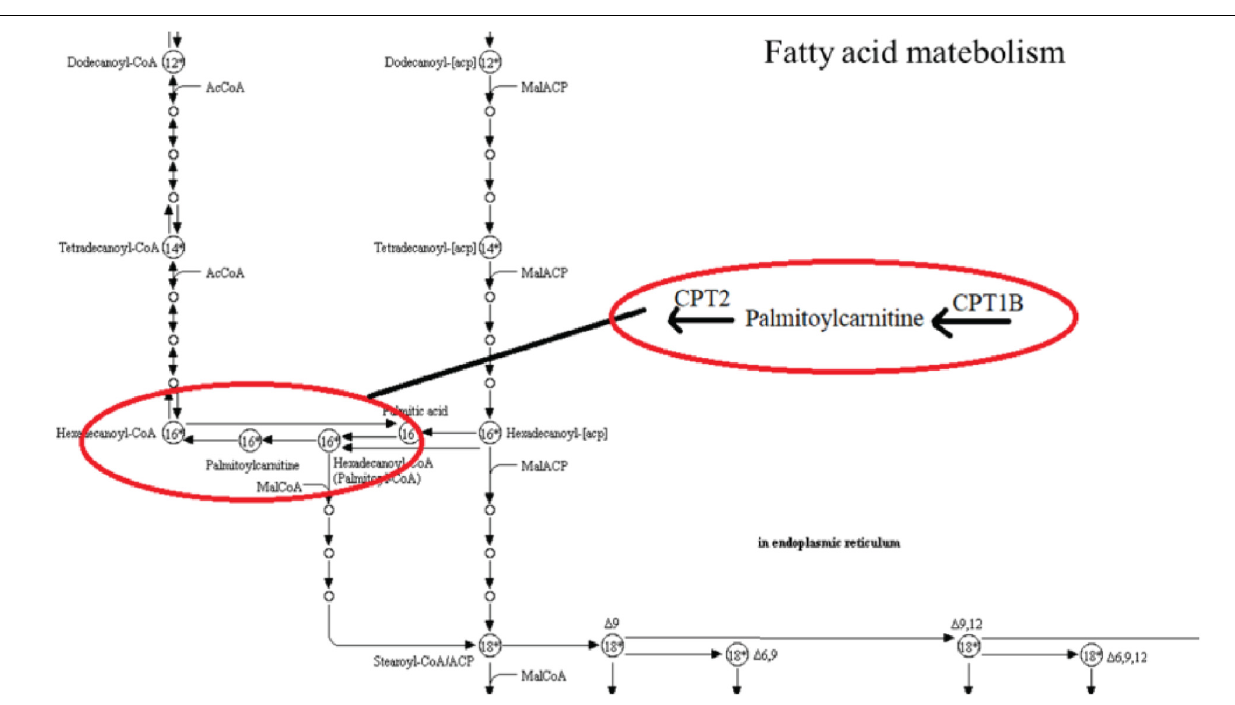
pathway databases in Cytoscape ( Figures 11B,C ). There are no biological processes and pathways related with cortical metabolites. Three proteins (CRAT, CPT1B, and CPT2)